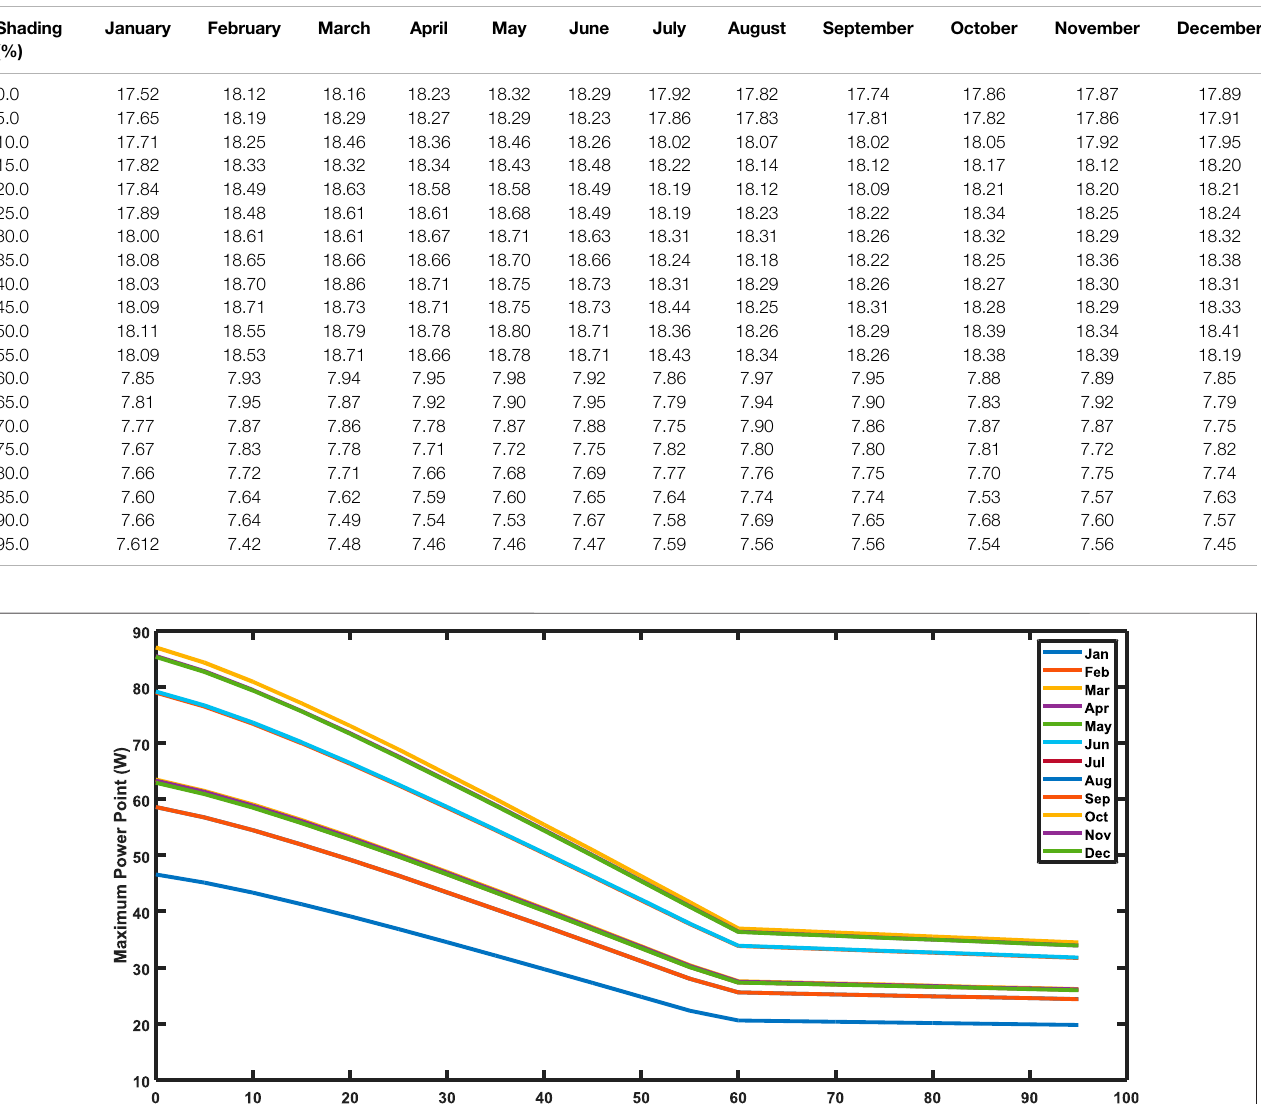
TABLE 6 | Monthly V mp with shading.